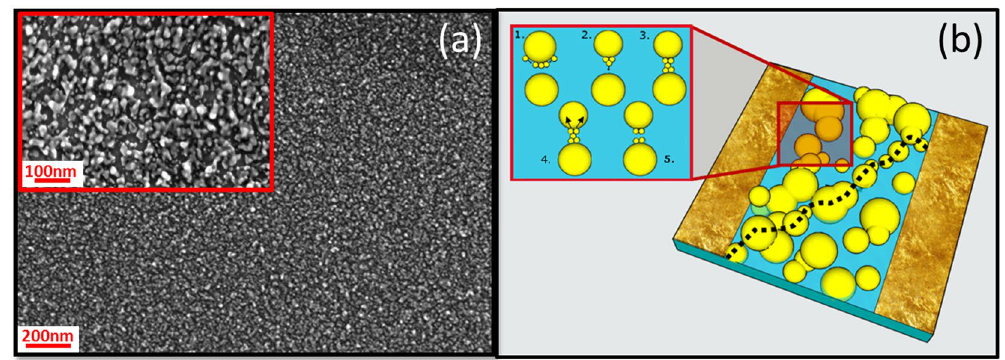
Figure 3. SCBD Au-Glass thin film. (a) Au clusters deposited on glass substrate with SCBD acquired with a Field Emission Scanning Electron Microscopy (FEG-SEM). (b) Schematic illustration of a percolating- tunneling system. A tunneling path is marked with a dashed line. In the inset the main phenomena which can lead to the formation of an atomic scale wire in a tunnel gap are depicted: 1. EFISD or van der Waals forces; 2. EFIE process; 3. Connected atomic wire. 4. Electromigration affecting the atomic wire: 5. Breaking of the atomic wire due to